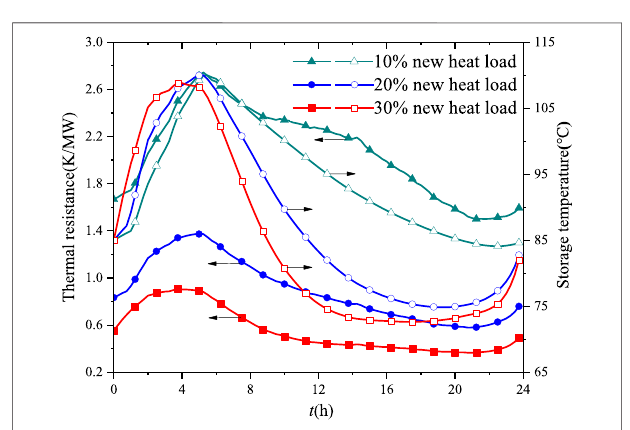
FIGURE 14 | Thermal resistance and storage temperature varying with new heat loads.